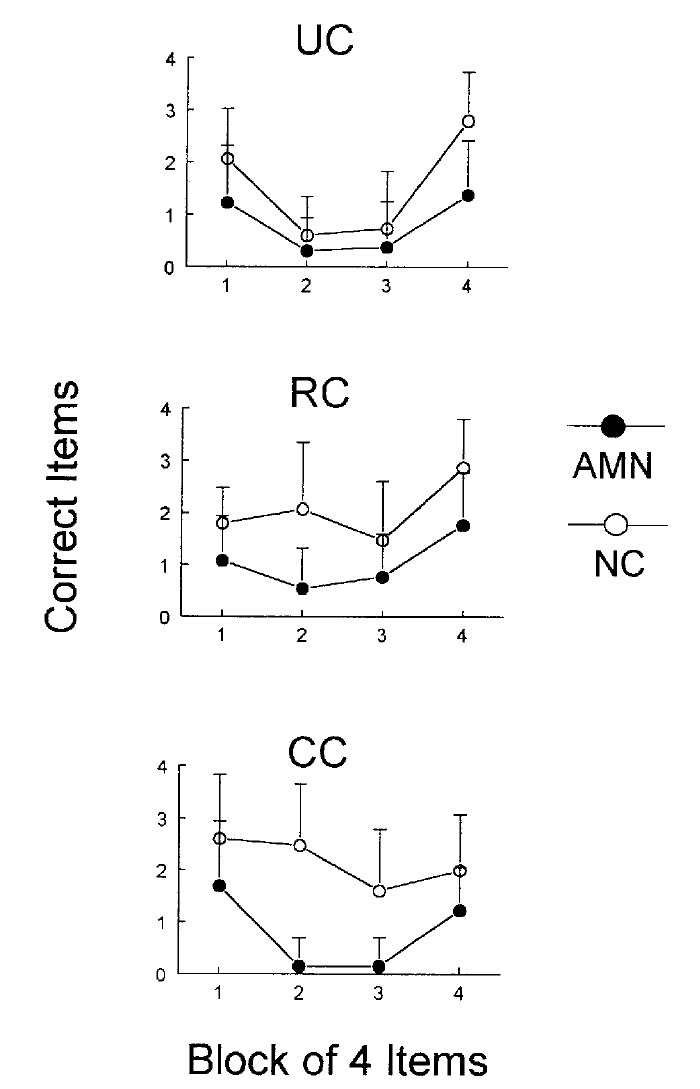
Fig. 2. Mean scores (and SDs) for serial position effects for amnesic (AMN) and control participants (NC) (UC = uncategorised list, RC = random categories, CC = consecutive